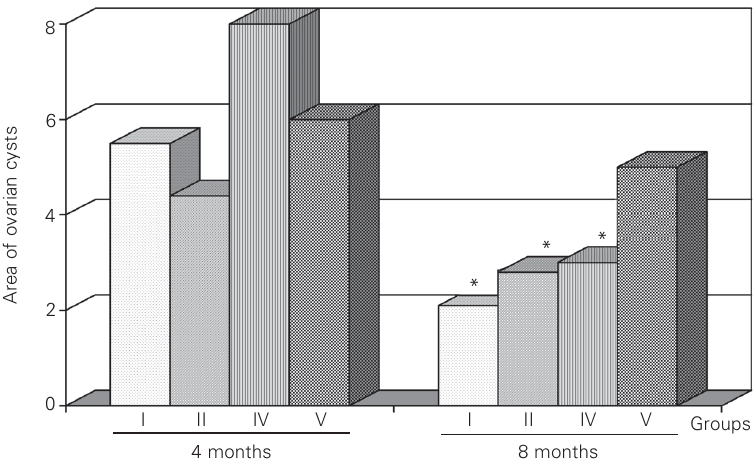
Figure 1. Number of cysts in the right ovary at 4 months and in the left ovary at 8 months before and after melatonin or placebo administration. Group I: pinealectomized ovariecto- mized melatonin-treated group; group II: pinealectomized ovariectomized placebo-treated group; group IV: continuous light ovariectomized melatonin-treated group; group V: con- tinuous light ovariectomized placebo-treated group. *P < 0.05 compared to 4 months (Wilcoxon nonparametric test).